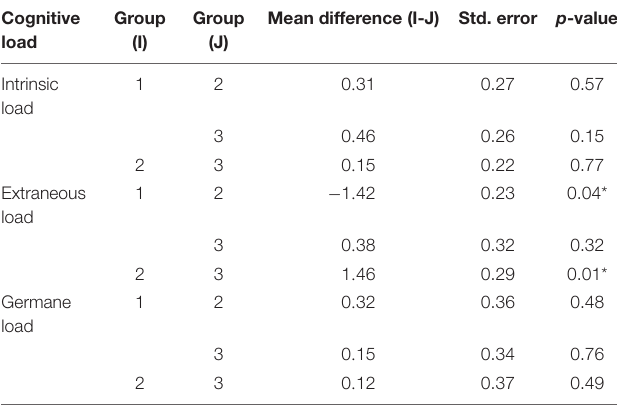
TABLE 3 | Post hoc test of the three groups’ cognitive load. Cognitive load